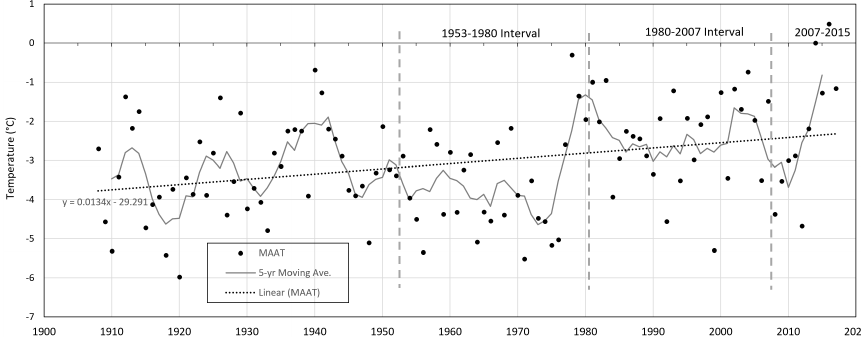
Figure 11. Mean annual air temperatures from 1908 to 2017 at Nome, Alaska (NOAA